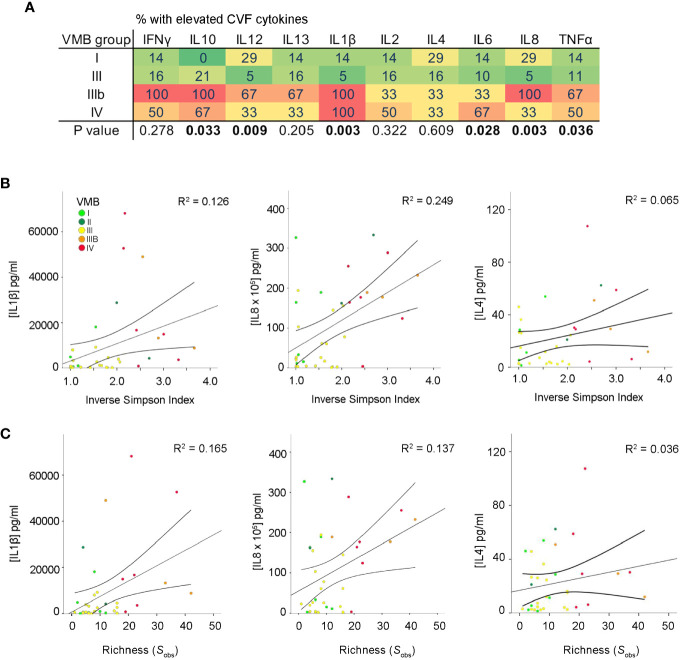
Increased vaginal microbial diversity and richness associates with local inflammation in PWLWH. (A) Heat map displaying proportion of t1 samples with elevated CVF cytokines in each VMB group defined by the cytokine concentration being in the upper quartile. A positive correlation between both IL-1β and IL-8 was observed between (B) α-diversity (Inverse Simpson Index) and (C) richness (species observed; Sobs) in PWLWH. No such correlations were observed for IL-4 or the remaining cytokines assessed.